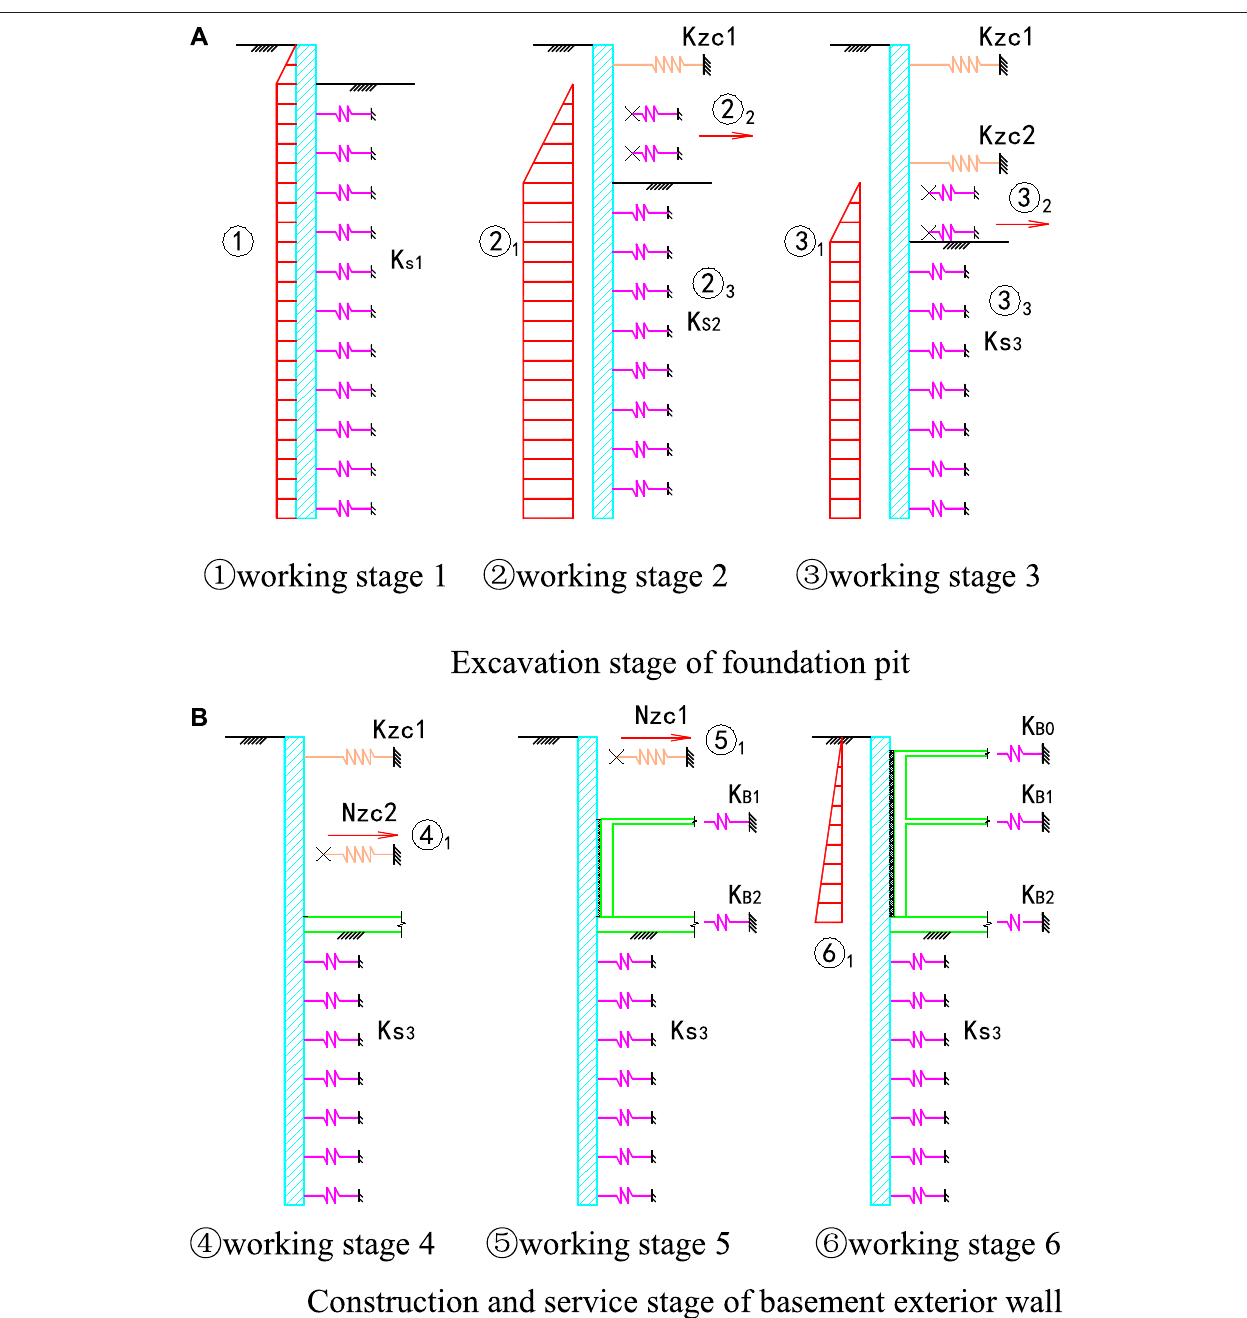
FIGURE2| Calculationdiagramofthewholeconstructionprocessofthefoundationpit ① Workingstage1 ② Workingstage2 ③ Workingstage3. (A) Excavation stage of the foundation pit ④ Working stage 4 ⑤ Working stage 5 ⑥ Working stage 6. (B) Construction and service stage of the basement exterior wall.